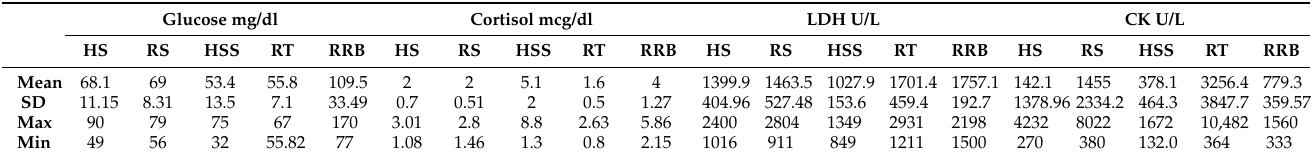
Table 2. Data set for physiological parameters.